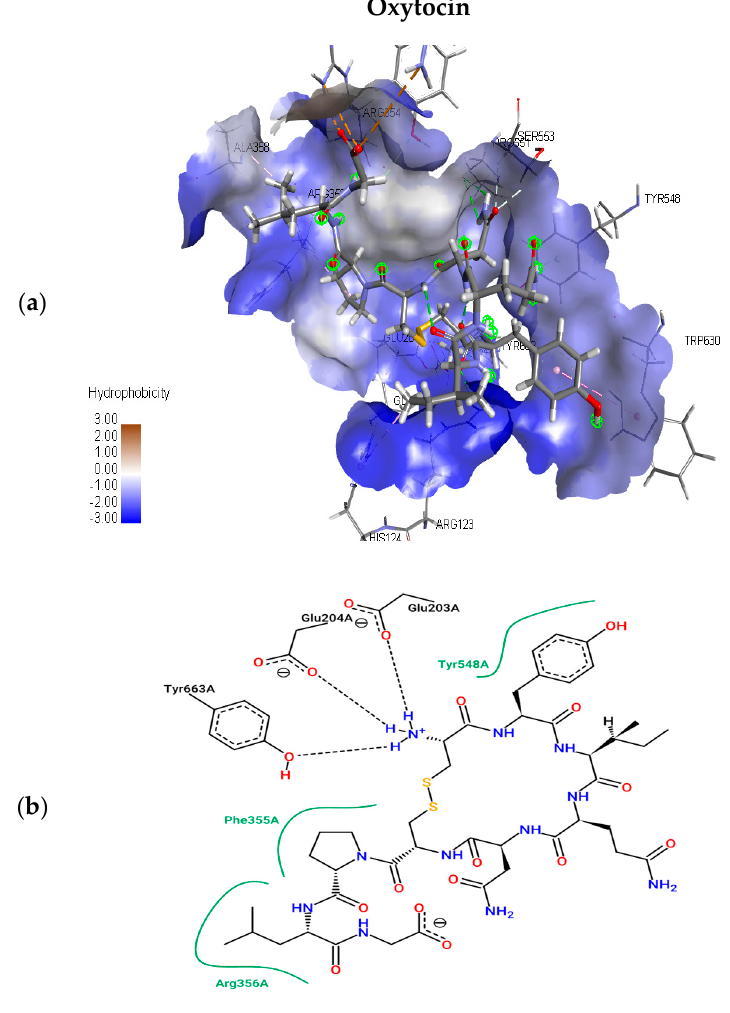
Figure 3. Top scoring binding pose views of oxytocin at the active site of DPP4 ( a ); and two-dimensional study of interacting residues ( b ), involved at the binding pose of oxytocin.